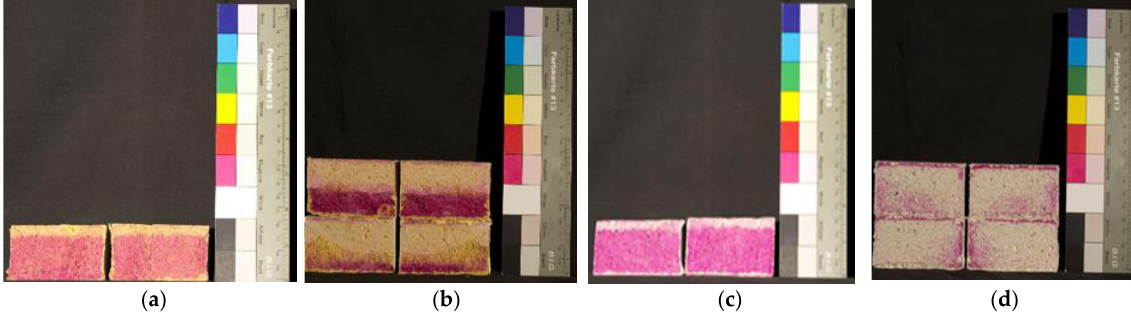
Figure 2. Carbonation depth: ( a ) YEL4% 7 days; ( b ) YEL4% 128 days; ( c ) WRM0.6 7 days; ( d ) WRM0.6 128 days.